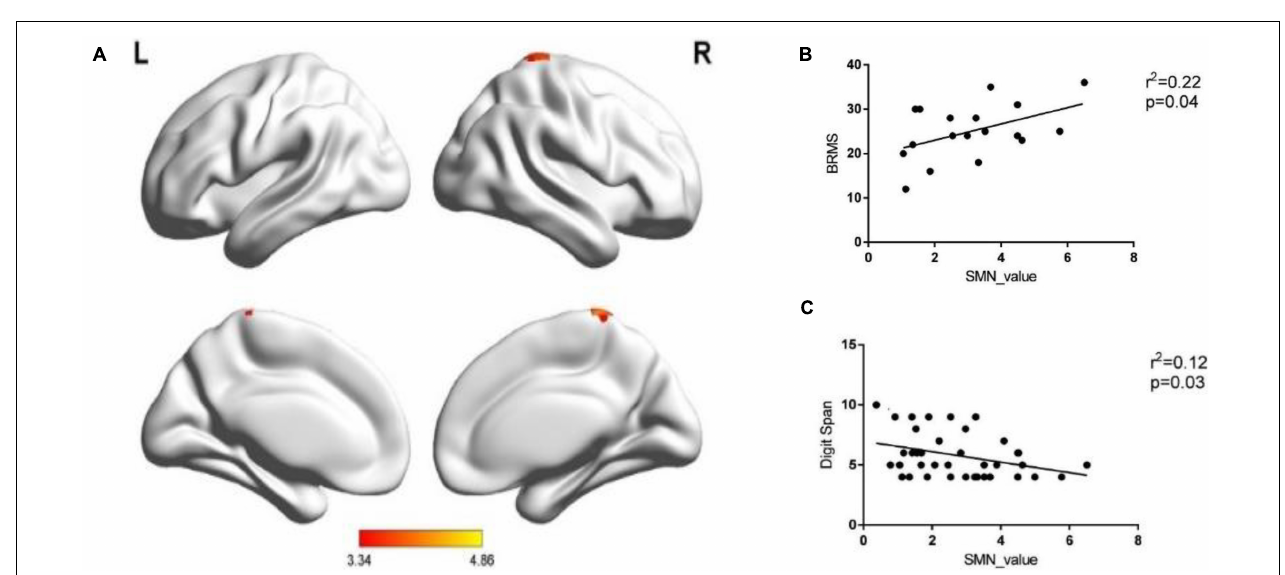
FIGURE 1 | Spatial distribution of the nine independent components for all HC and BD-I subjects. Components 8 and 13 were found to match with the SMN. DMN, default mode network; rFPN, right frontoparietal network; DAN, dorsal attention network; SMN, sensorimotor network; AN, auditory network; VN, visual network.